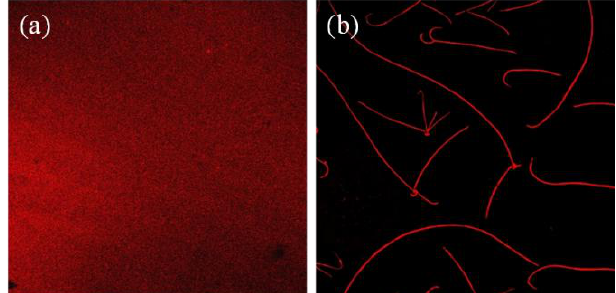
Figure 4. Confocal fluorescence microscope images of spin-coated thin film from PDI 8 -CN 2 /PMMA (1:20 w / w ratio) 1,2-dichlorobenzene solution on Si/SiO 2 substrate before ( a ) and after ( b ) SVA process. Excitation wavelength was ~559 nm, all peaks of their fluorescence spectra ranged from ~655 nm to ~755 nm, with red emission.